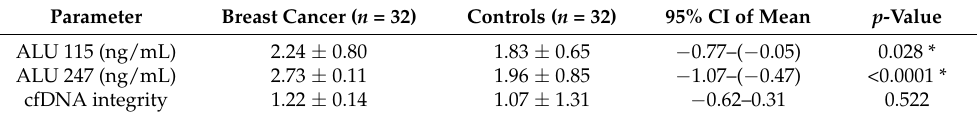
Table 4. Serum cfDNA concentrations and DNA integrity before chemotherapy (T1).